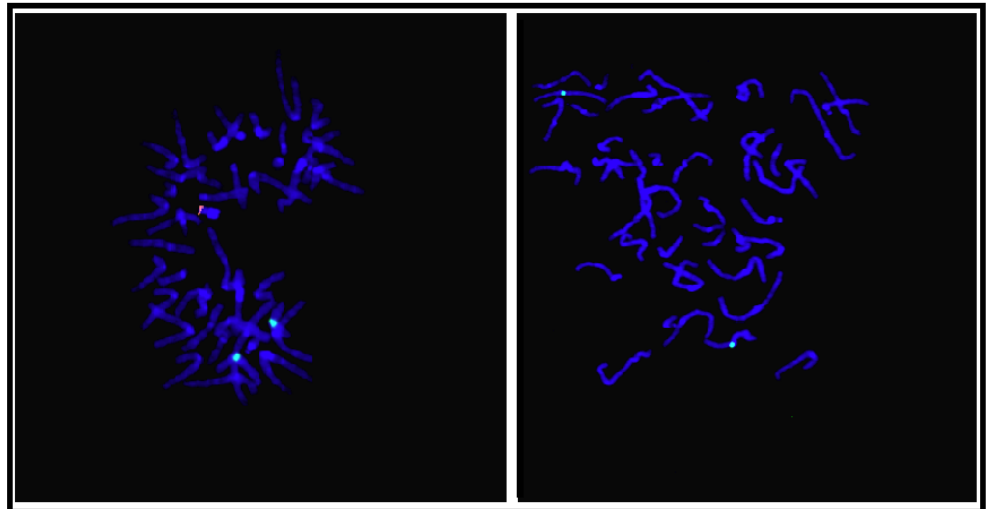
Figure 1. FISH analysis showing mosaic karyotype 47,XXY/46,XX using dual-colour FISH probe—Vysis LSI SRY (Spectrum Orange)/CEPX (Spectrum Green) (Abbott Molecular).